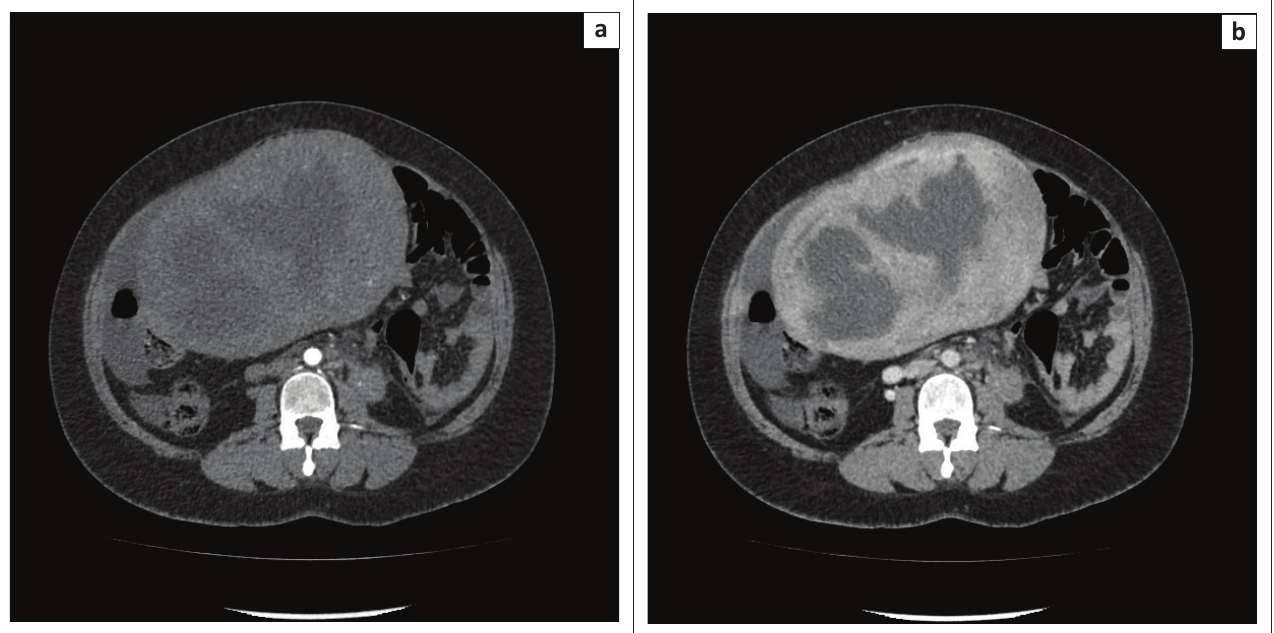
FIGURE 1: Axial computed tomography of the abdomen during (a) arterial and (b) portal venous phases showing a large centrally hypodense mid-abdominal mass with a thick enhancing wall and